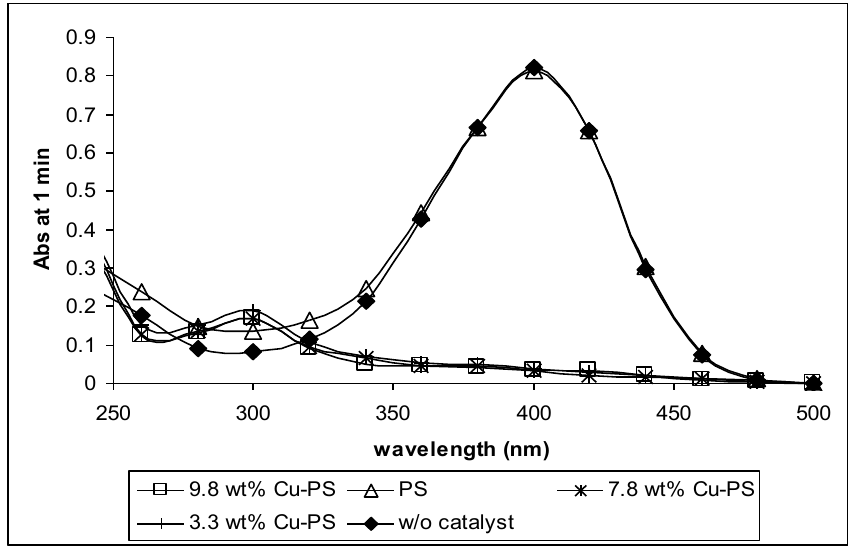
Figure 7. UV spectra of solution containing p-nitrophenol and KBH 4 with (PS or Cu-PS) and without catalysts at 1 min of